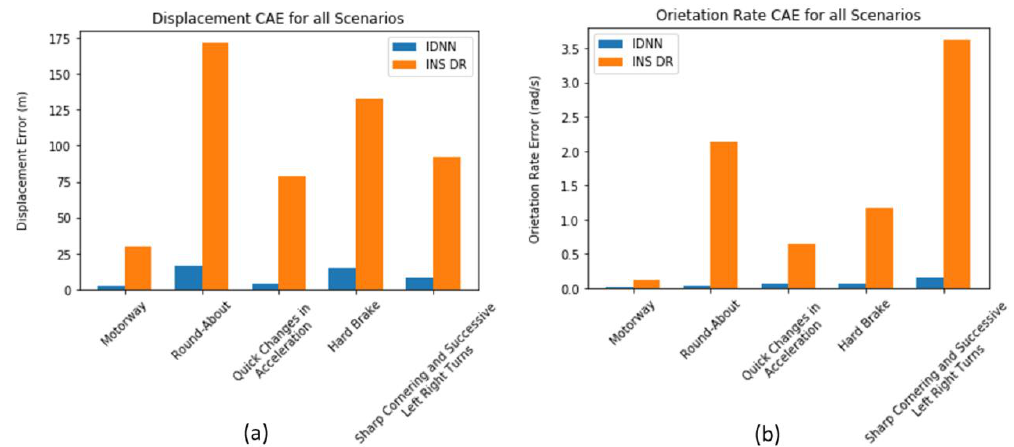
Figure 5. Showing the comparison of the CAE performance of the IDNN and INS DR across all investigated scenarios on the ( a ) displacement estimation and ( b ) orientation rate estimation.